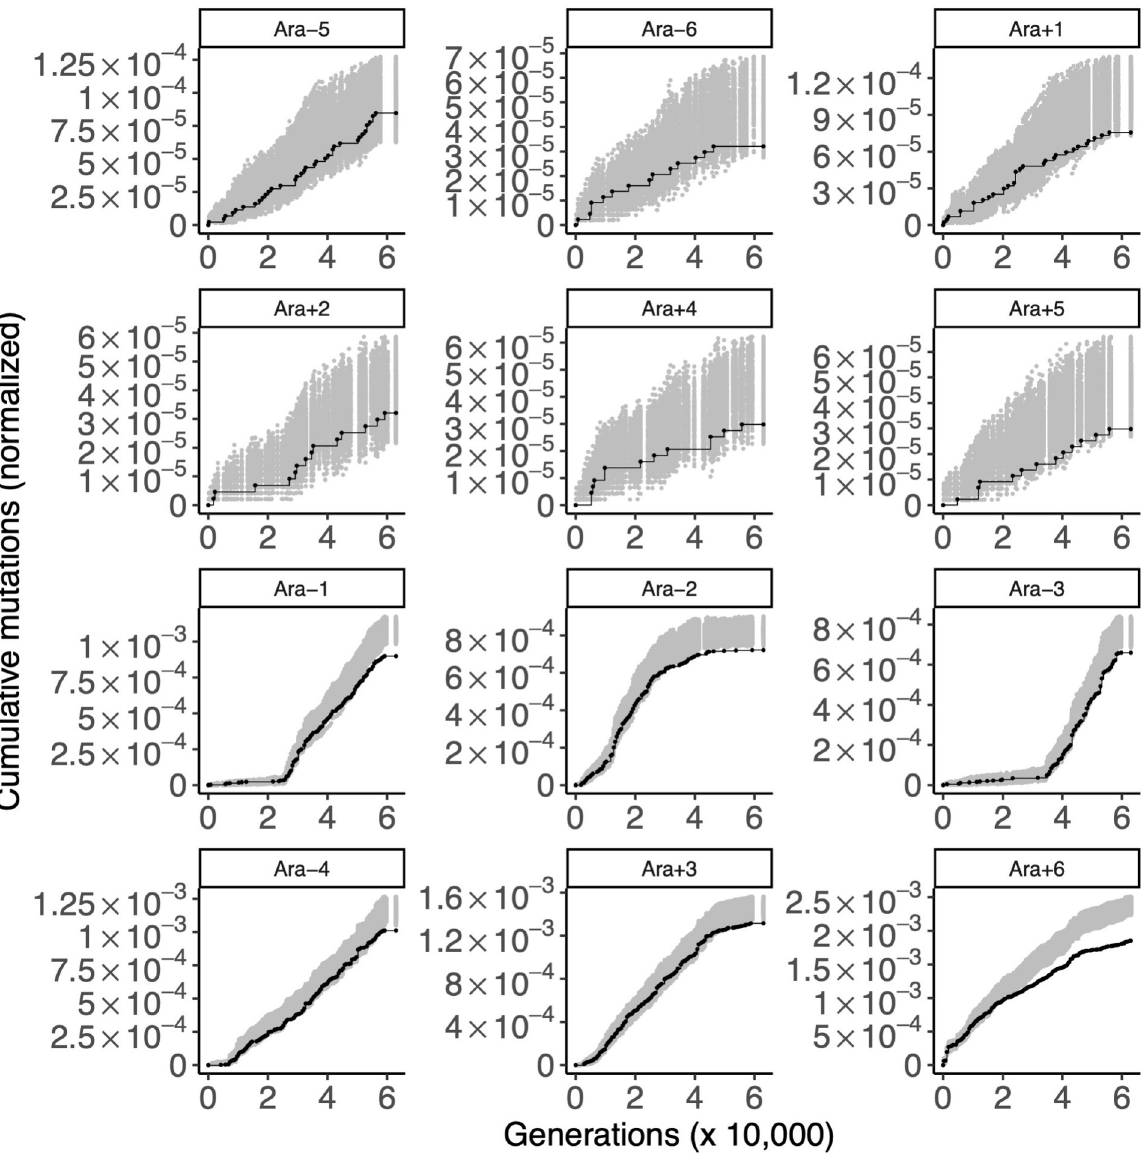
Fig 6. Gold-standard genes under purifying selection. Each panel shows the cumulative number of mutations in the gold standard set of genes under purifying selection (black) in the 12 LTEE populations. For comparison, random sets of 490 genes were sampled 1,000 times, and the cumulative number of mutations in those random gene sets, normalized by gene length, were calculated. The middle 95% of this null distribution is shown in gray. The top six panels are the nonmutator populations and the bottom six panels are the hypermutator populations.